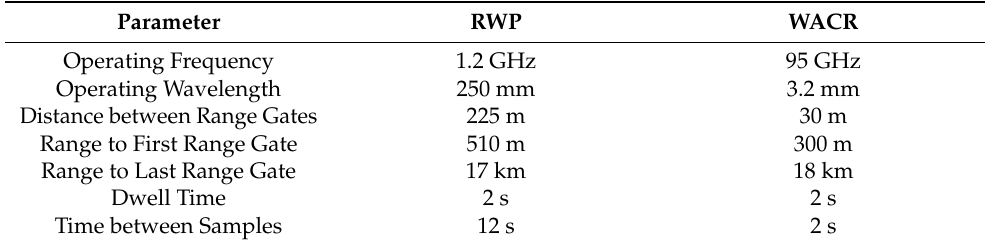
Table 1. Pertinent Radar Wind Profiler (RWP) and W-band ARM Cloud Radar (WACR) operating parameters during the GOAmazon field campaign. Parameter RWP WACR Operating Frequency 1.2 GHz 95 GHz Operating Wavelength 250 mm 3.2 mm 225